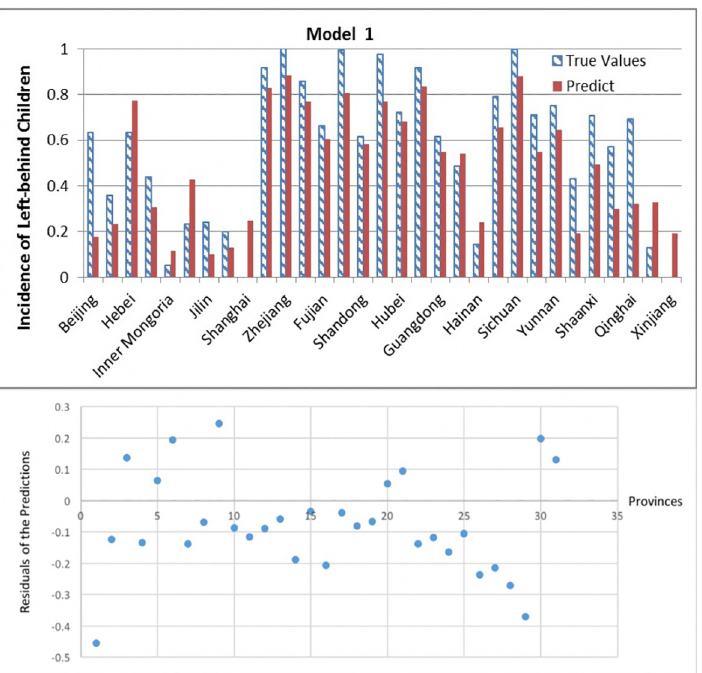
Fig 9. Prediction results and residuals of Model